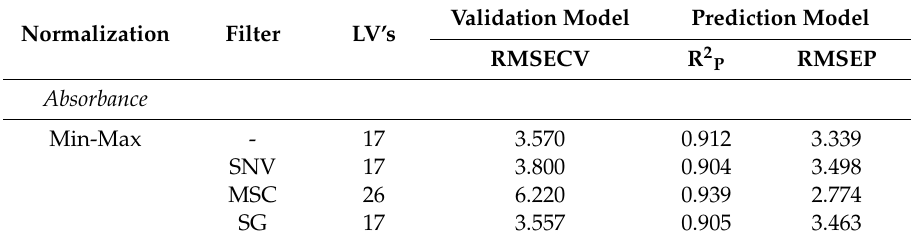
Table 3. Performance of PLSR for prediction TWC based on 100